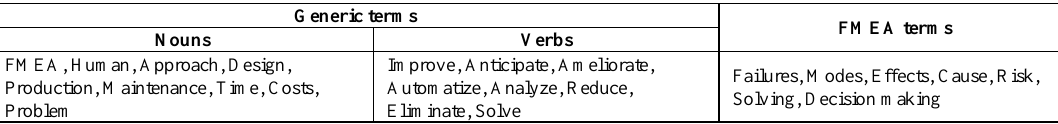
Table 1. Initial keywords used to search the queries.